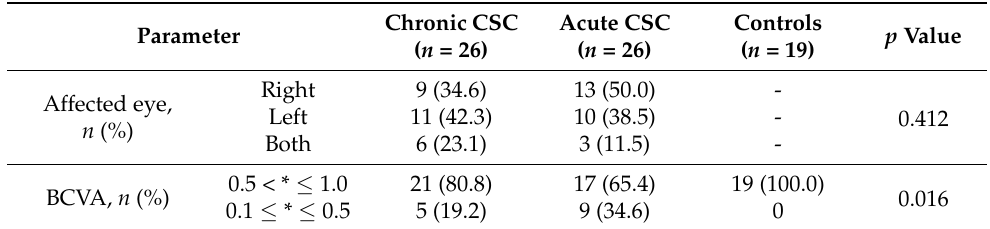
Table 2. Ophthalmological characteristics of patients with acute central serous chorioretinopathy (CSC), patients with chronic CSC, and